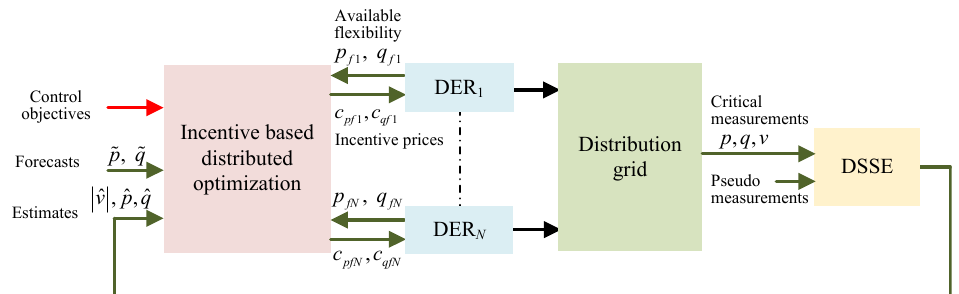
Figure 2. Schematic diagram of distributed predictive control of DERs based on incentive